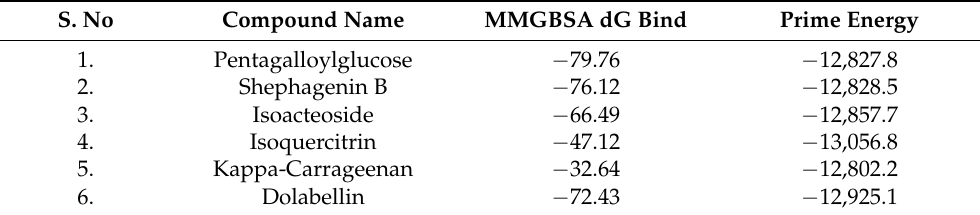
Figure 7. ( K , L ) Illustrations of the interaction between Dolabellin and the target M pro protein of SARS-CoV-2. Table 3. MM-GBSA scores of the six selected phytocompounds docked with the target M pro protein of